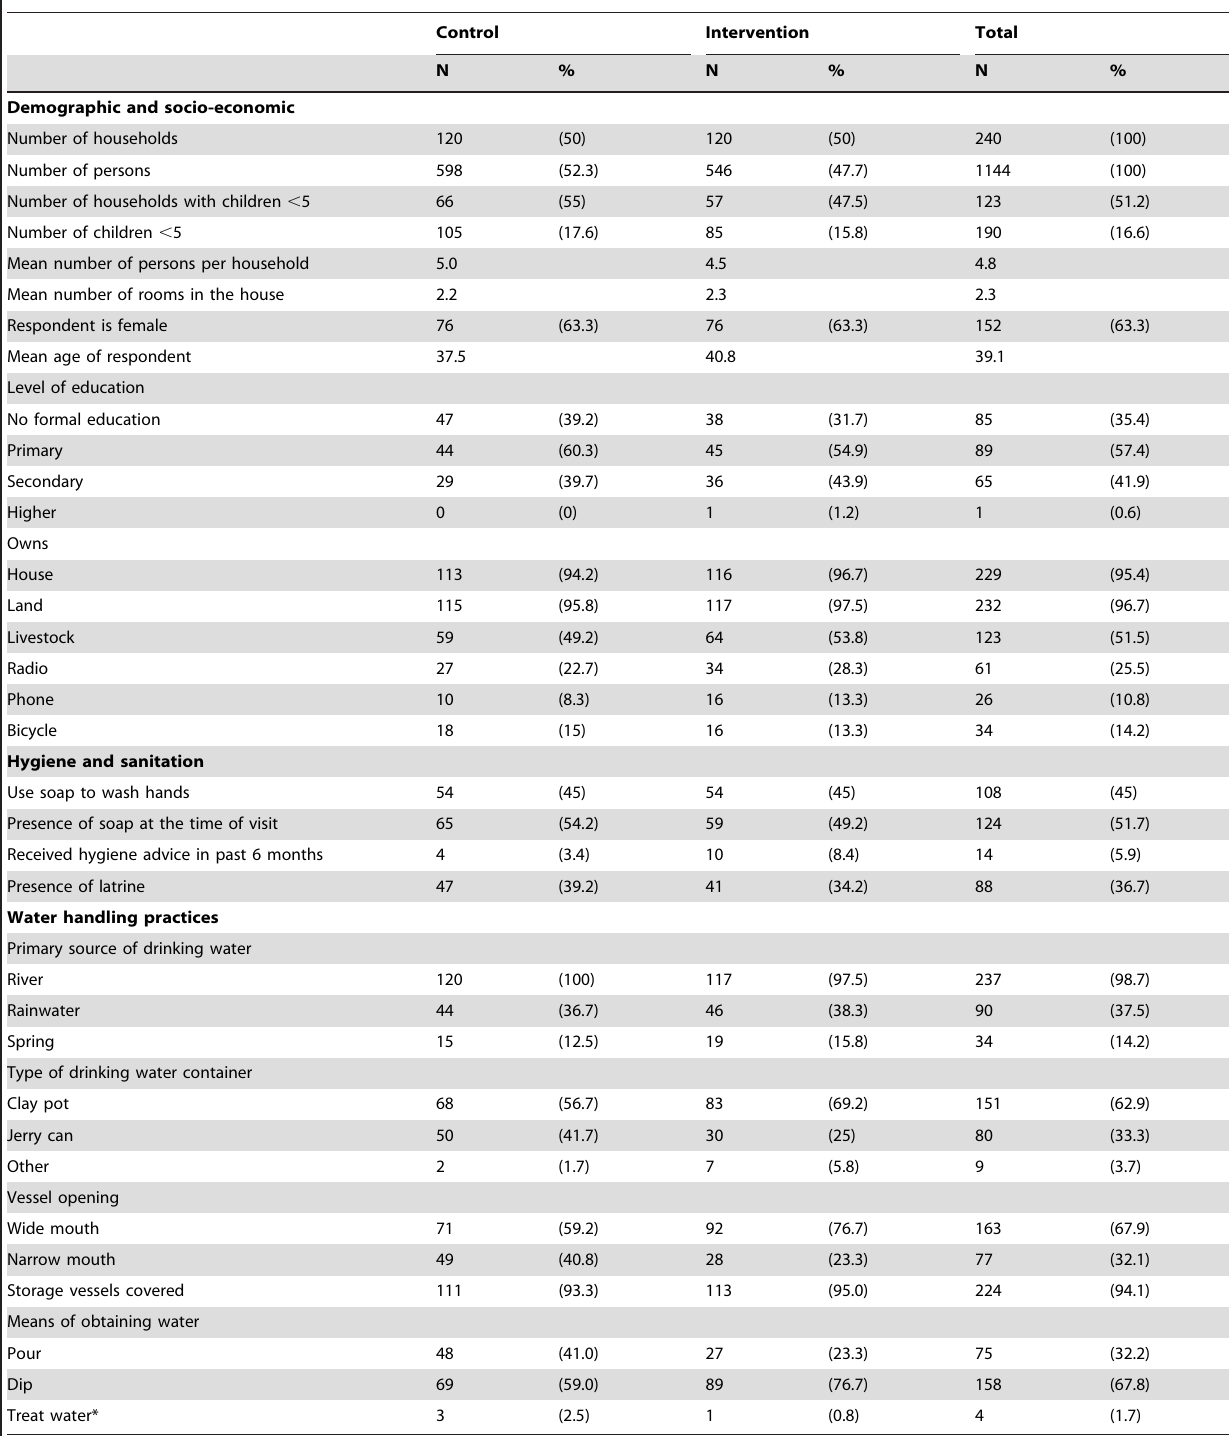
Table 1. Baseline characteristics of participating households.